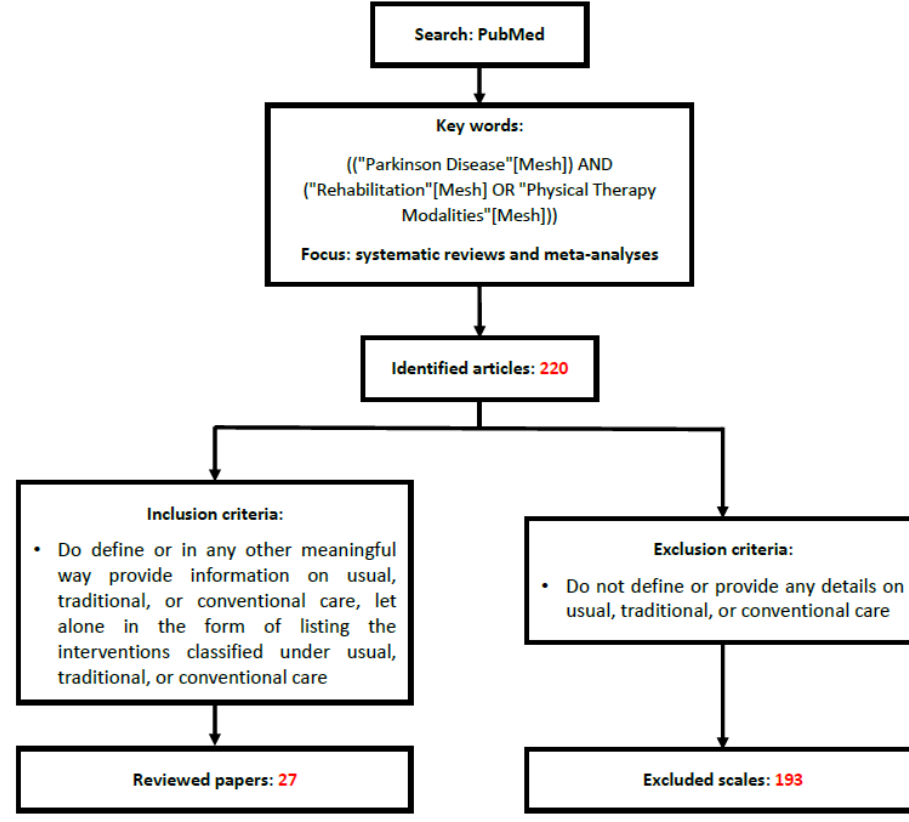
Figure 1. Flowchart of the review process.